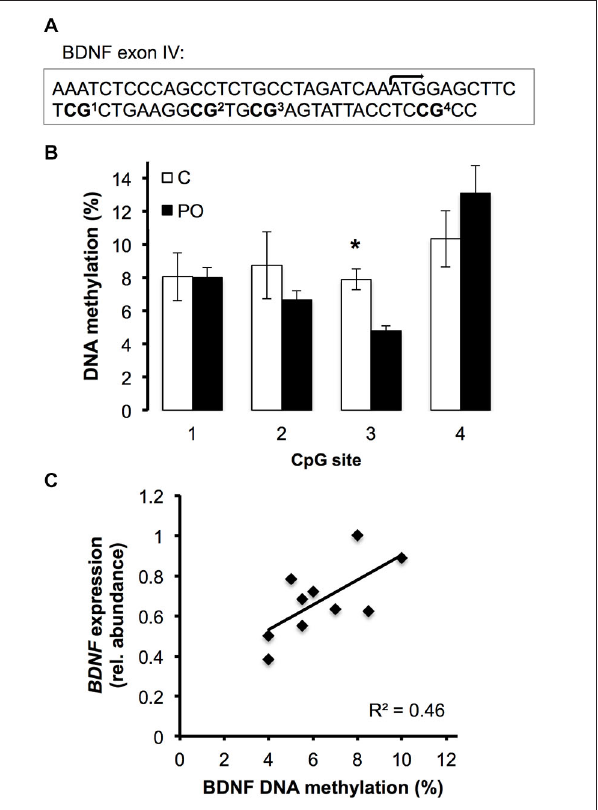
FIGURE 6 | DNA methyation level of the Bdnf exon IV in the hippocampus of female offspring of predator odor exposed (PO) and control (C) dams . (A) Region sequenced with transcription initiation site (bent arrow) and CpG sites. (B) DNA methylation level (%) of the 4 sequenced CpG sites. (C) Correlation between the hippocampal BDNF expression and the hippocampal Bdnf exon IV CpG3 methylation level (%) ( P = 0.03). Data are average ± SEM. * P ≤ 0.05, effect of maternal predator